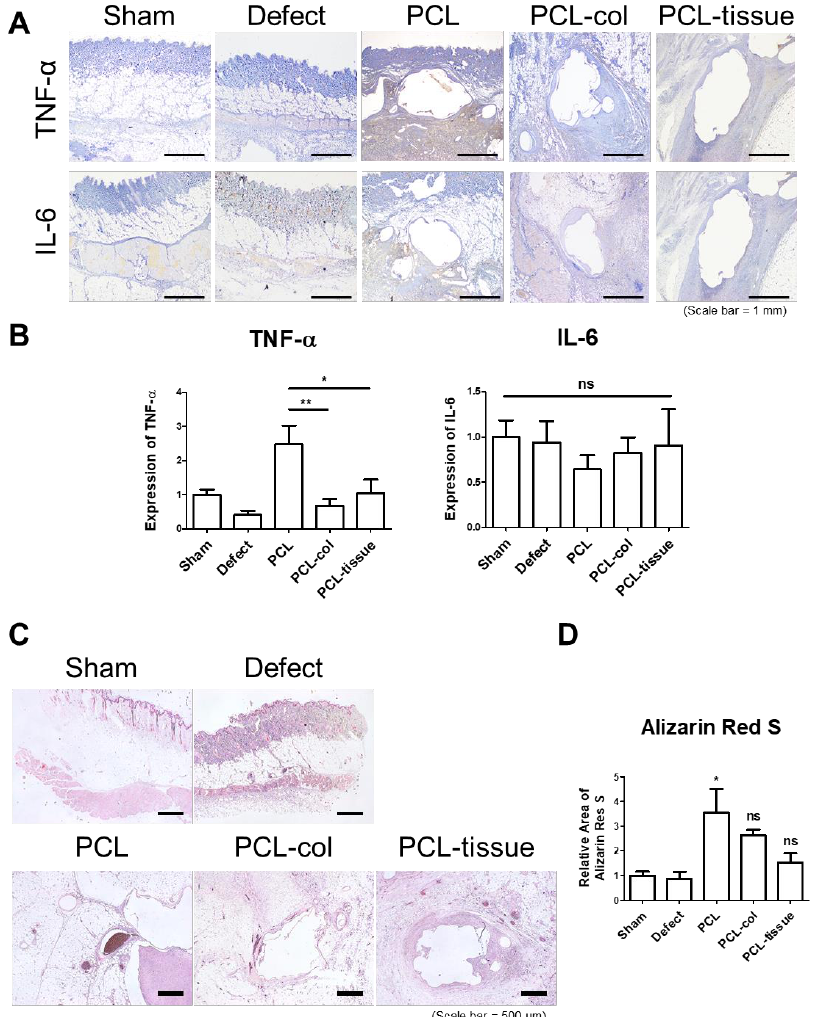
Figure 4. Evaluation of the inflammatory properties of the PCL scaffold. ( A ) Immunohistochemistry analysis of TNF- α and IL-6 after PCL scaffold implantation (Scale bar = 1 mm); ( B ) Quantitative analysis of the expression of TNF- α and IL-6 (* p < 0.05, ** p < 0.01); ( C ) Alizarin red S staining after PCL scaffold implantation (Scale bar = 500 µ m); ( D ) Quantitative analysis of Alizarin red S staining (* p <